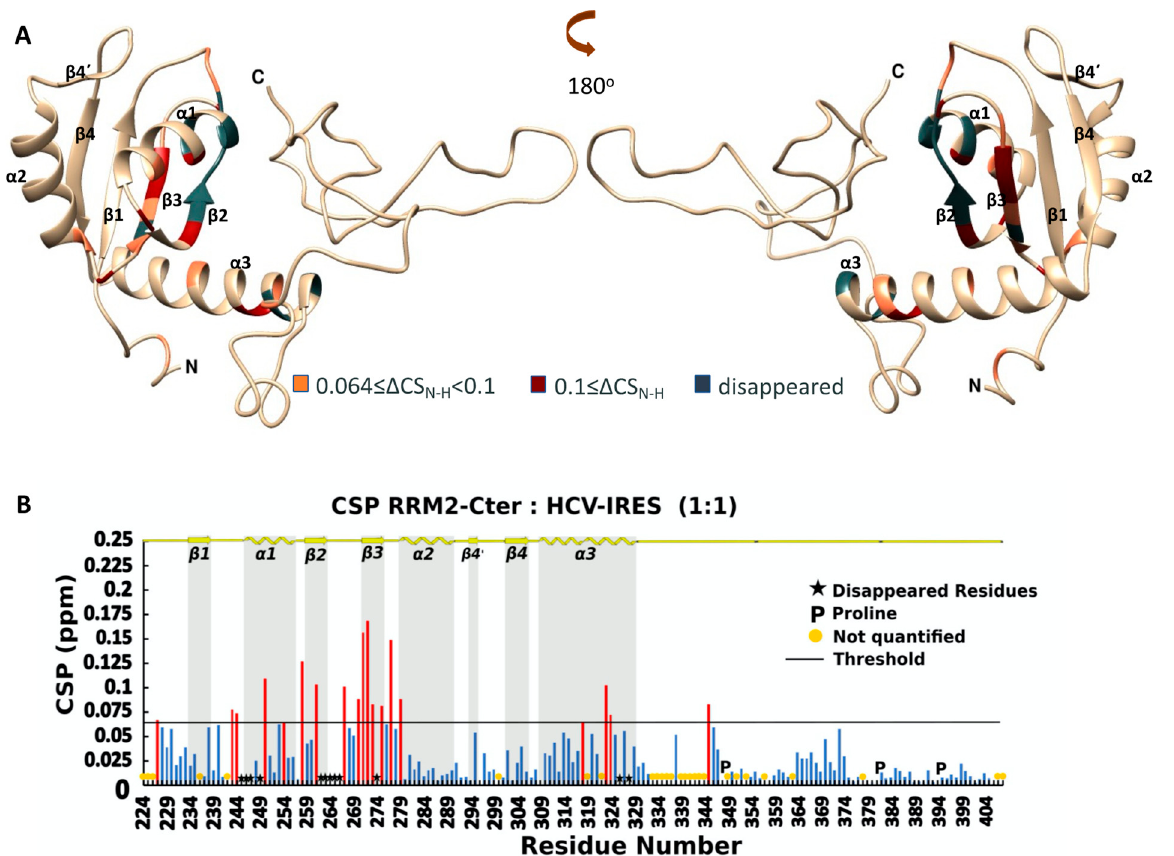
Figure 4. ( A ) Ribbon representation of the affected amino acids mapped into the hRRM2-Cter structure; ( B ) chemical shift perturbation of 15 N-hRRM2-Cter upon the addition of the unlabeled ligand in threshold value 0.064. Red bars indicate CSPs above threshold, while blue bars illustrate CSPs beyond threshold line.